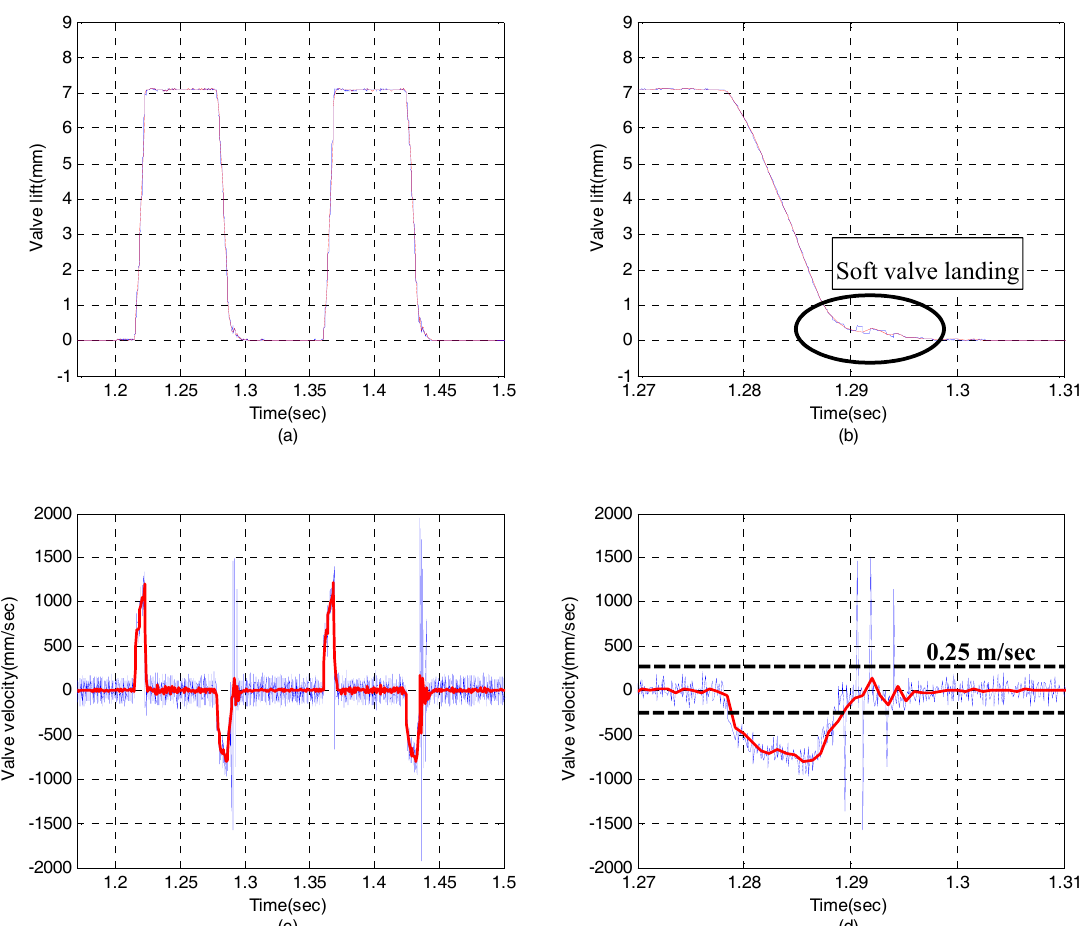
Figure 10. Experimental results for an EH-CEVA with the 0.3 mm of snubber orifice. (blue line: raw measurement data, red line: measurement data with a low-pass filter): ( a ) valve lift profile, ( b ) zoomed in valve lift profile, ( c ) valve velocity profile, ( d ) zoomed-in valve velocity profile.